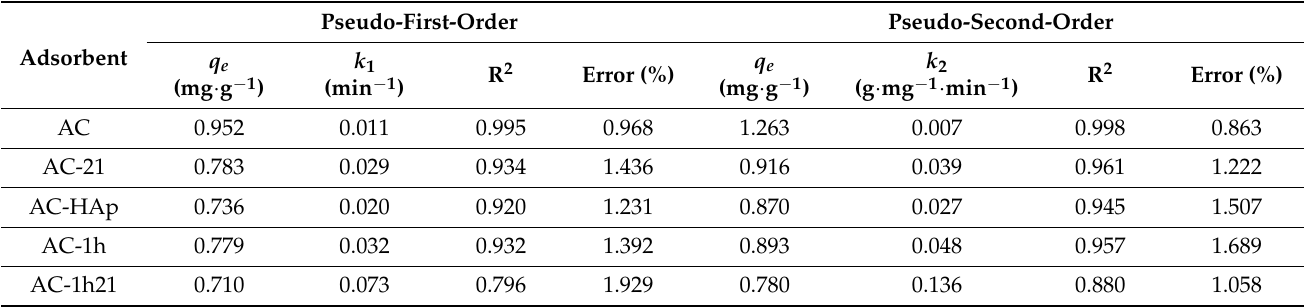
Table 3. Parameters of kinetic